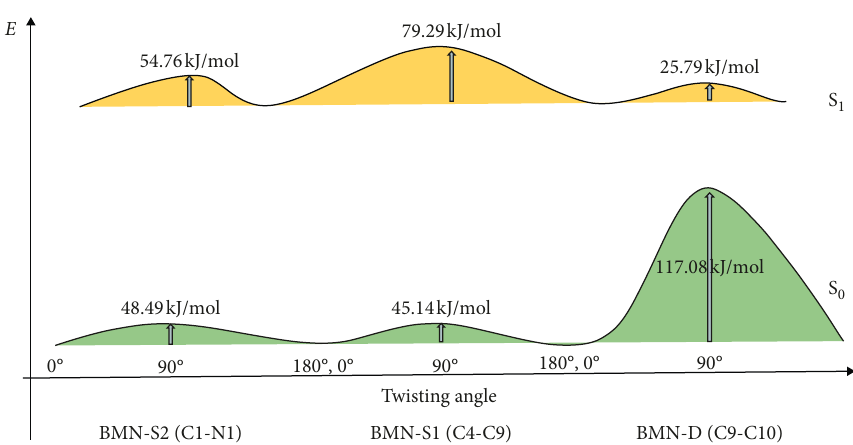
Figure 5: Relative potential energy diagram in the ground and first excited state of the BMN molecule. The arrows represent relative destabilization energy at 90 ° twist angles around each bond. B3LYP/DEF2-SV(P) was used for computing the thermodynamic data.